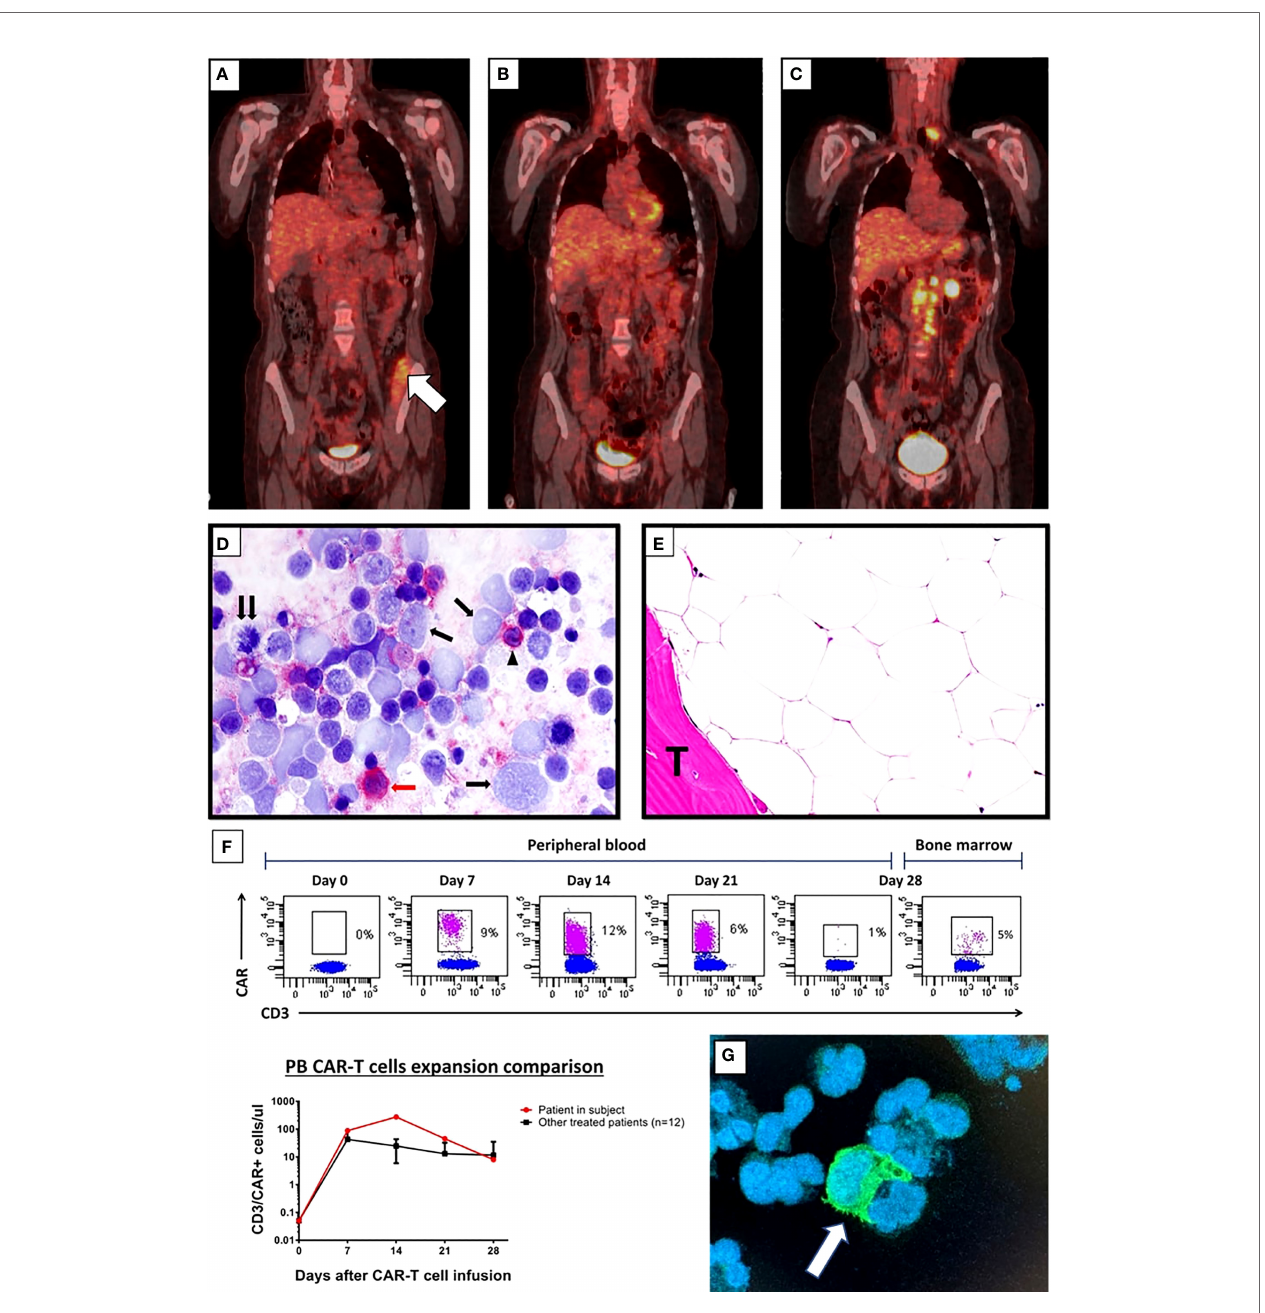
FIGURE 2 | (A – C) FDG-PET/CT coronal maximum intensity projection (MIP) image after sTLI/TMI and before CAR T cells; white arrow in (A) indicates metabolic uptake in the iliopsoas muscle (A) FDG-PET/CT after CD19-directed CAR T cell therapy showing metabolic complete response at 6 months (B) and DLBCL relapse at 11 months (C) . (D) Imprint of latero-cervical lymph node at relapse immunostained for the CD19 CAR target (detected in red). Almost all large lymphoma cells appear CD19-negative (single arrows); the double arrow points to a CD19-negative tumor cell in mitosis. The red arrow indicates a CD19 positive (red) large tumor cell while the arrowhead indicates a CD19 positive (red) normal small B lymphocyte (Alkaline Phosphatase Anti-Alkaline Phosphatase (APAAP) technique; ×400). Negativity of >95% of tumor cells for CD19 was also con fi rmed in frozen and paraf fi n sections of the lymph node (not shown). (E) BM biopsy taken 11 months after CAR T cell infusion showing a markedly hypocellular marrow without lymphoma in fi ltration. T indicated BM trabecula. (Hematoxylin – Eosin; ×400). (F) Flow cytometry plots showing CAR T cells detected in the CD3+ T-cell subsets in the peripheral blood every week the fi rst month after CAR T cell infusion and in bone marrow aspirate at day 28-disease assessment (top). Comparison of CAR T cell absolute count expansion between the patient in subject and mean of the other treated patients in our center (n = 12) at indicated time points after CAR T cell infusion (bottom). CAR T cells were detected staining anti-CD19 CARs by the biotinylated CD19 CAR detection reagent (Miltenyi) together with anti-biotin-APC. (G) Immuno fl uorescence image stained by biotinylated CD19 CAR detection reagent (Miltenyi) together with anti-FC FITCH conjugated secondary antibody (Thermo-Fisher, green) and DAPI (for cell nuclei, blue) performed on cytospin preparation from the peripheral blood of the patient obtained 14 days after CAR T cell infusion. The white arrow indicates a CAR T cell probably embracing a leukemic B